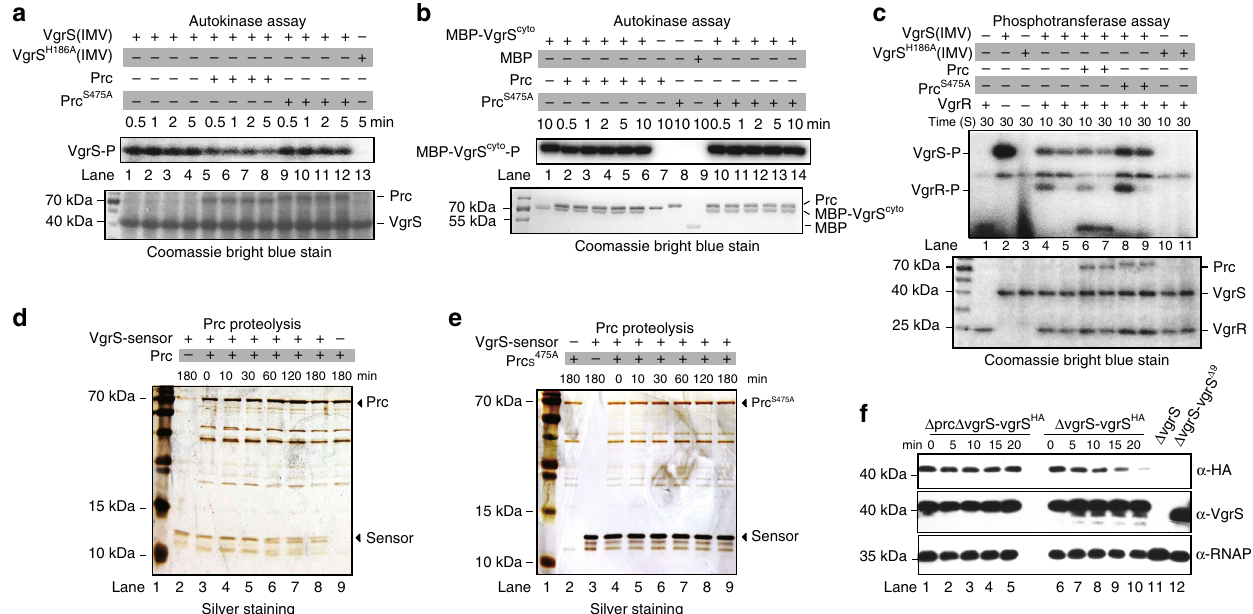
Fig. 4 Prc cleaves the sensor region of VgrS to inhibit its autokinase activity. a – c Prc inhibited full-length VgrS autophosphorylation in a protease activity- dependent manner. a Full-length VgrS embedded in the inverted membrane vesicles (IMV, 10 μ M) was phosphorylated by [ γ - 32 P]ATP. Before the addition of 10 μ Ci [ γ - 32 P]ATP, active Prc or inactive PrcS 475A (2 μ M) was added into the mixture. VgrS H186A IMV was used as a negative control of phosphorylation. b Prc did not affect the autophosphorylation of a soluble, cytosolic fragment of VgrS. In total, 10 μ M soluble VgrS containing the transmitter region (MBP-VgrS cyto ) was used in the assay. c Prc inhibited the phosphorylation level of VgrR. After VgrS autophosphorylation, 10 μ M VgrR was added into the mixture to elicit the VgrS – VgrR phosphotransfer reaction. In a , b and c : Upper panels show autophosphorylation assays; lower panels show Coomassie bright blue-stained gels used to check the amount of loaded protein. Aliquots were removed from the mixture at the indicated time points. The reaction was stopped by 6X SDS buffer, separated by SDS-PAGE and analysed by autoradiography. d and e Prc degraded the VgrS sensor in vitro. The puri fi ed VgrS sensor (100 μ M) was co-incubated with 5 μ M active Prc d or inactive Prc S475A e in enzymatic reaction buffer at 28 °C for the indicated time. Reactions were stopped, and the products were analysed by SDS-PAGE together with silver staining. f Western blotting revealed that Prc degraded N-terminal HA-tags in vivo. A bacterial strain that encoded recombinant VgrS fused with an HA-tag between the 6th and 7th residues was constructed independently in the Δ vgrS background. The bacterial strain was stimulated by 1.0 M sorbitol for different time periods. Total proteins were extracted, separated by SDS-PAGE, and analysed by western blotting. A polyclonal antibody of VgrS ( α -VgrS) was used to measure the amount of VgrS protein, while monoclonal HA antibody ( α -HA) was used to detect the N-terminal region of VgrS that was potentially cleaved by Prc, and the polyclonal antibody of RNAP ( α -RNAP) was used as internal control. a – f , the experiments were repeated three